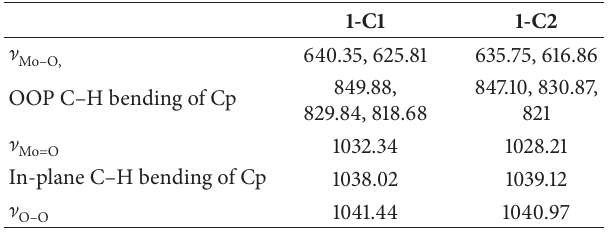
Table 1: Key vibrational modes and their calculated